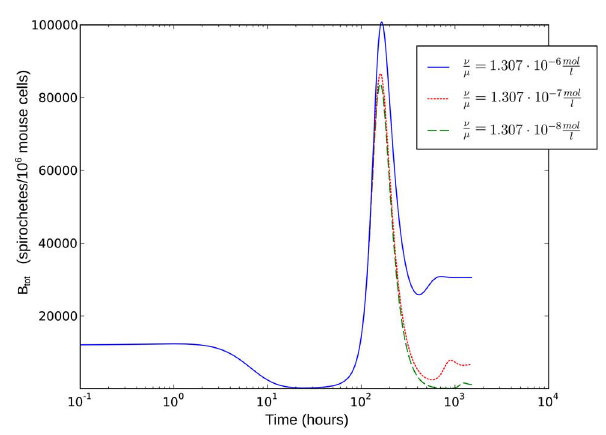
FIGURE 9 | Single-site model with bacterial adaptation and adaptive immune reaction. Simulations were done with different values for ν shown in the